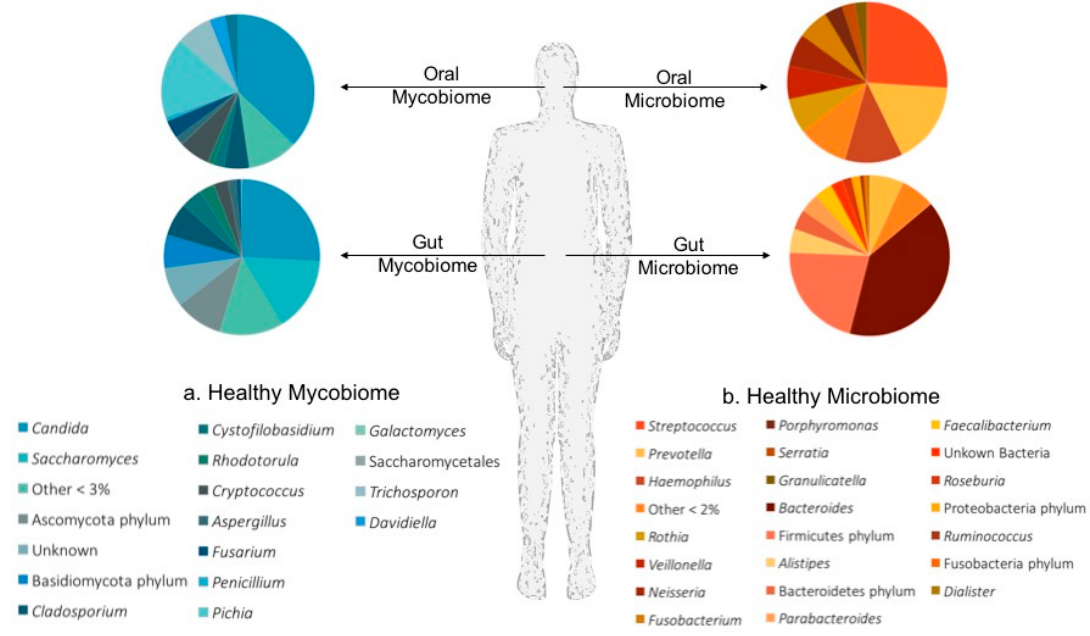
Figure 1. Healthy microbial communities of the human body. An overview of the Mycobiota ( a ) and Microbiota ( b ) identified on the mucosal surfaces of the oral cavity and lower gastrointestinal tract in a state of health. Pie charts depict the average relative abundance of fungal taxa ( a ); and bacterial taxa ( b ) observed in the healthy oral cavity [26], and gastrointestinal tract [27] of study participants.